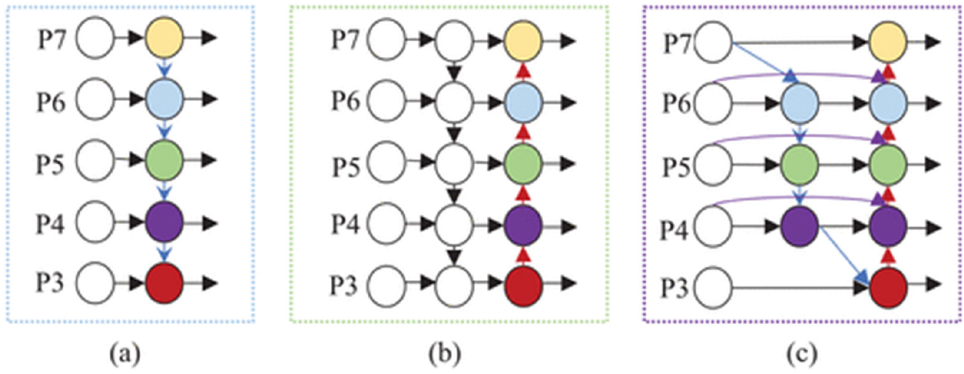
Figure 5. Feature fusion structural model diagrams: ( a ) FPN, ( b ) PAN, ( c ) BiFPN. P3-P7 represent features from different layers of the model.